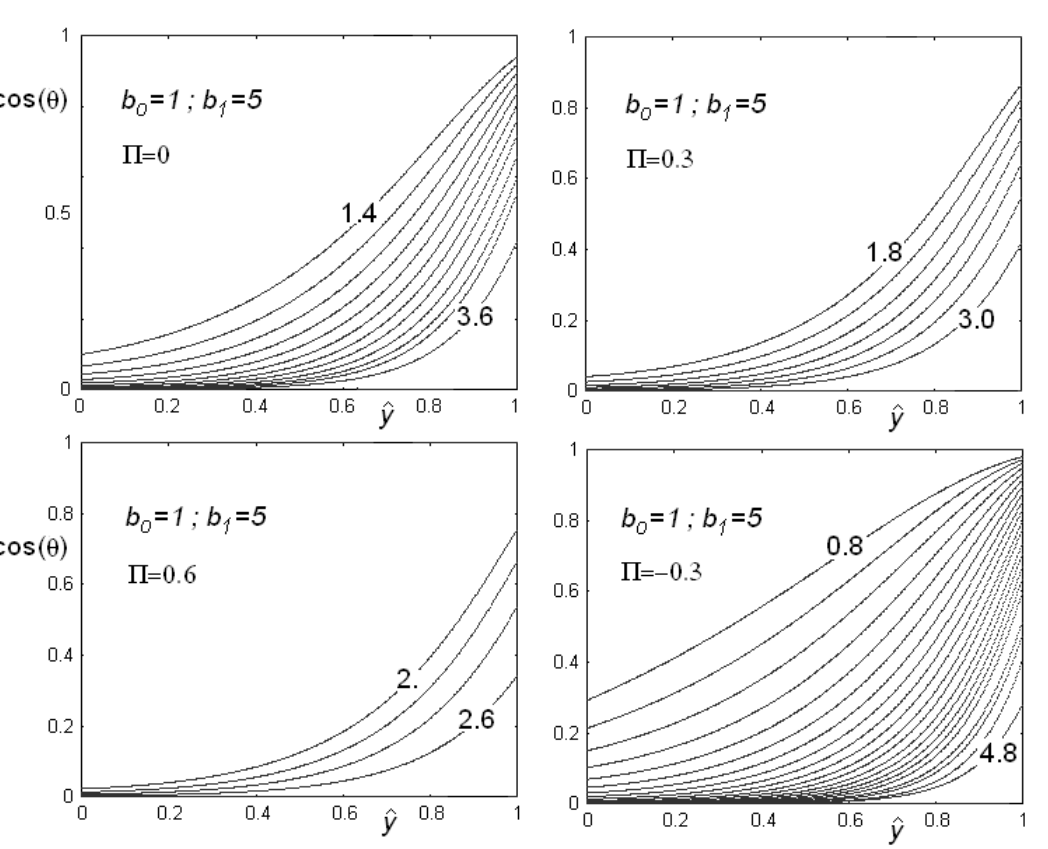
Figure 6. Behaviour of θ cos as a function of the reduced cell thickness dyy = ) in the case of positive and negative flexoelectric coefficients, for different values of the dimensionless electric field (some values are reported on the curves). Note that, as the field increases, the role of surface is suppressed and the angle at the planar surface increases. As the electric field is higher that the threshold value, the cell becomes homeotropic and then 0 = θ cos